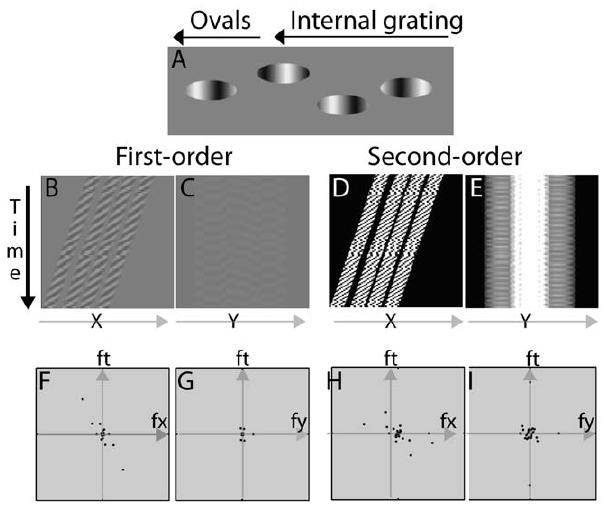
Figure 3. Motion energy analysis for the peripheral accelera- tion illusion (See Movie S2). A) A single frame of the peripheral acceleration illusion. Ovals drift from left to right across the screen. Inside each oval is an internal gradient that moves faster than the oval and in the same direction as the oval. When viewed foveally, observers can separate the ovals and internal grating; when viewed peripherally, the ovals appear to accelerate, and the interior of the oval appears fixed. B&C) First-order motion plots in the x-t and y-t planes. D&E) Projections of DC-removed and rectified second-order peripheral acceleration movie in the x-t and y-t planes. F–I) Fourier analysis of the first-order and second-order motion energy of the peripheral acceleration movie in the fx-ft and fy-ft planes.